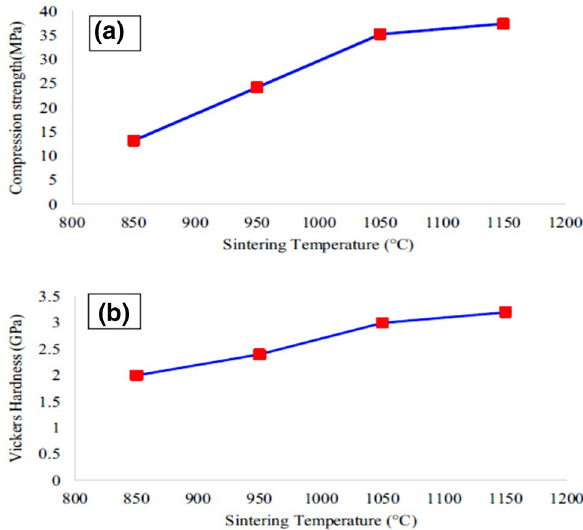
Fig. 21 Vickers hardness of sintered samples [113] Table 9 Young modulus and fracture toughness